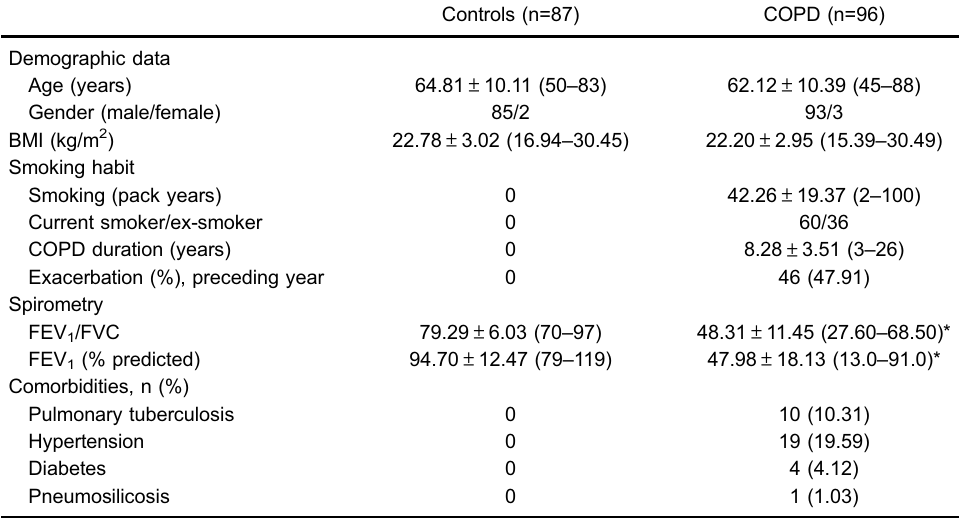
Table 1. Characteristics of the study groups.